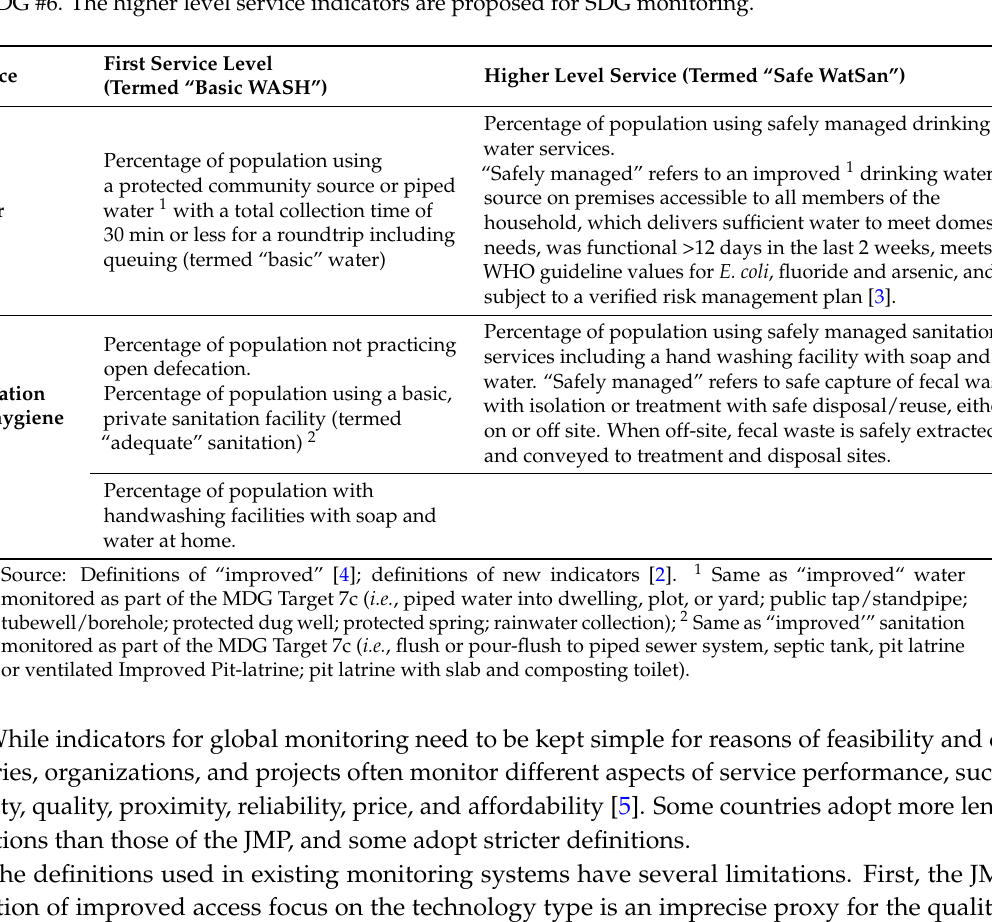
Table 2. Definitions of service levels proposed for monitoring of the WASH-related targets of the Water SDG #6. The higher level service indicators are proposed for SDG